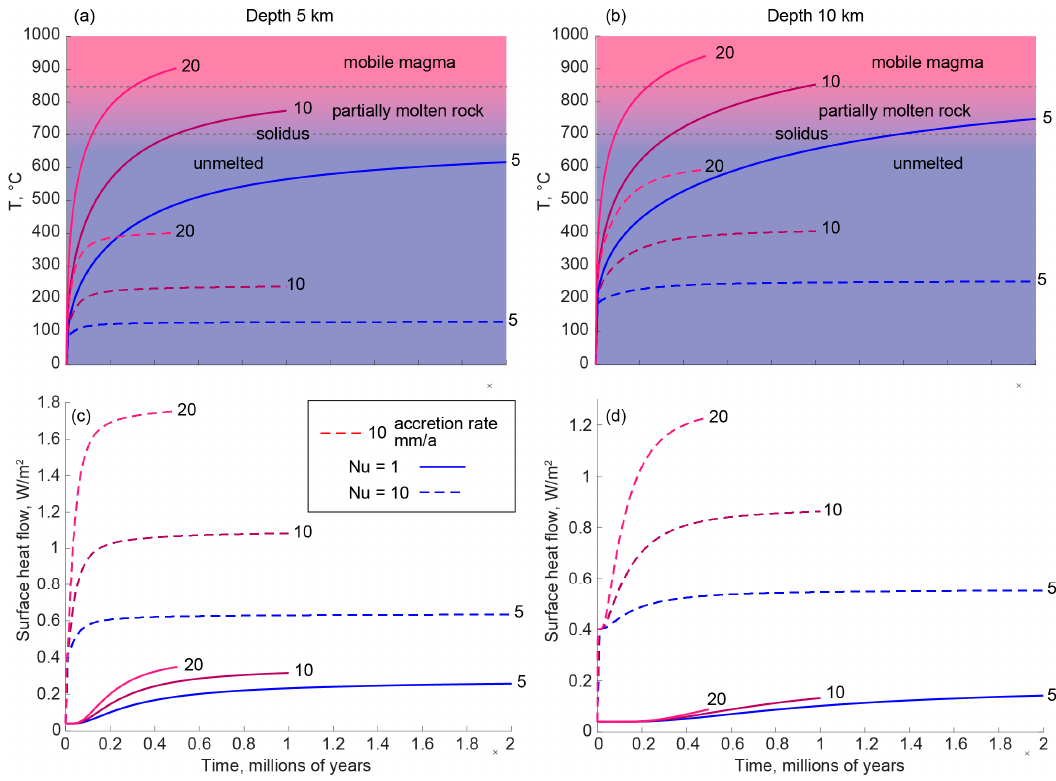
Figure 3. Thermal models of emplacement of 50 m sills at depths of 5 km ( a,c ) and 10 km ( b,d ), at rates of 5, 10, and 20 mm/a and Nusselt numbers of 1 and 10. ( a,b ) Maximum temperatures attained just before next injection of magma as a function of depth. Dotted lines at 700 and 850 °C are model solidus and 50 wt% melt, respectively; the latter is the approximate threshold for a mobile magma body. Models were run until 10 vertical km of magma was intruded. At 5 km, only the highest accretion rate produces a mobile magma body; at 10 km, both 10 and 20 mm/a models reach the 850 °C threshold. Heat flow ( c,d ) is far higher for the convective models with 𝑁𝑢 = 10 than for conductive models with 𝑁𝑢 = 1, reaching 1 W/m 2 or more for the faster accretion rates.